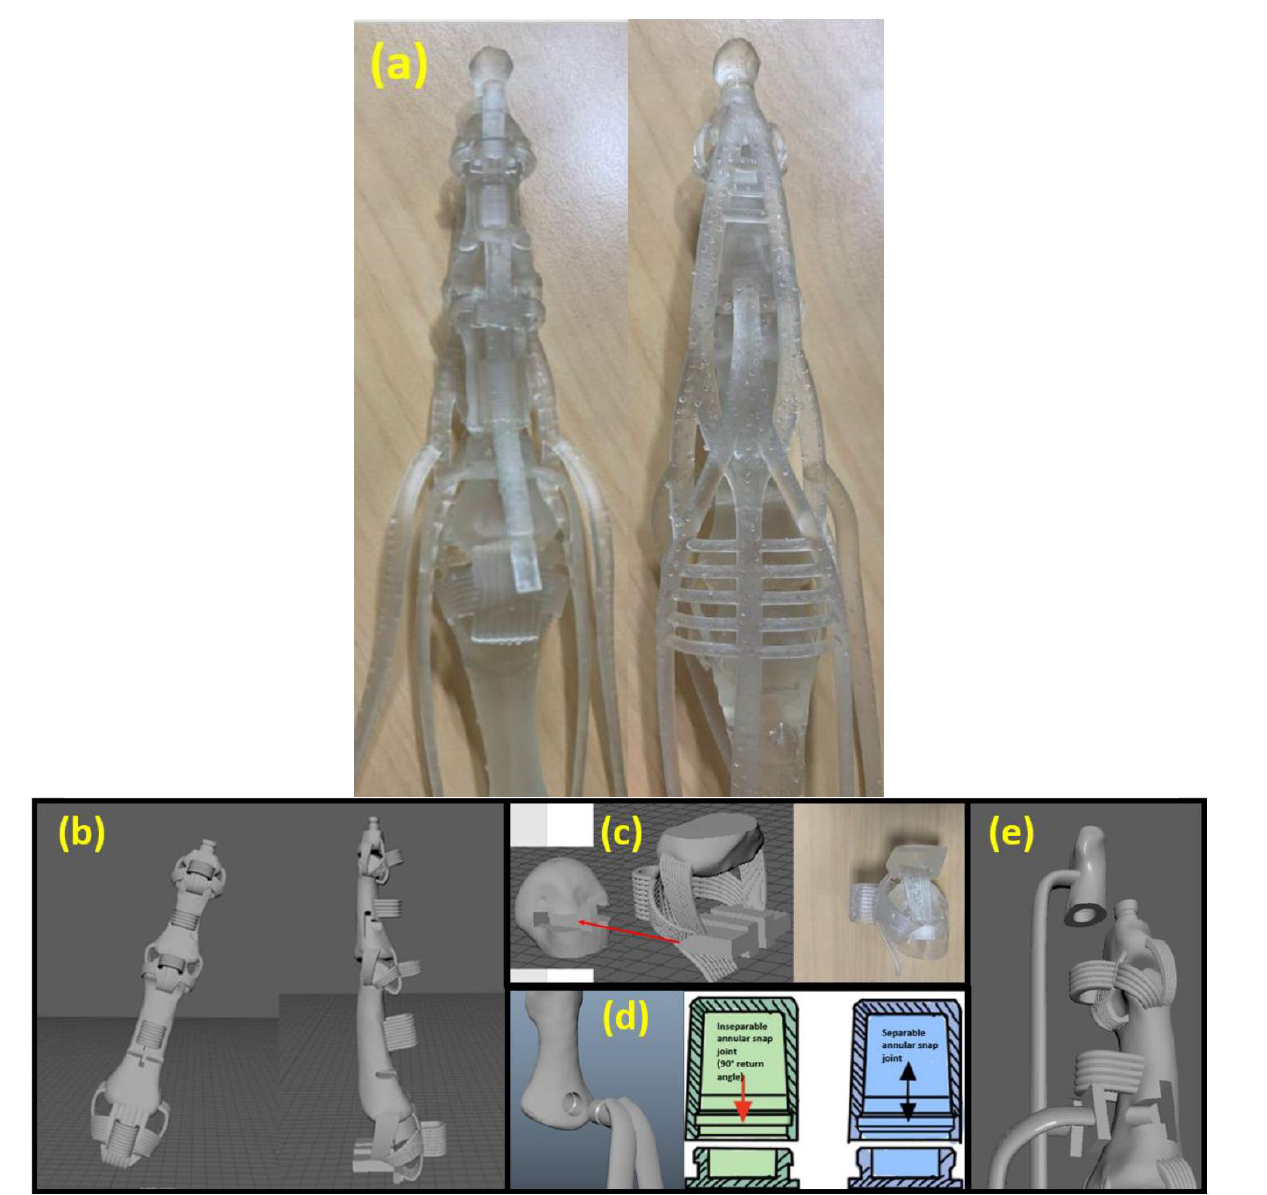
Figure 7. ( a ) Front and back view of our 3D-printed robotic finger; ( b ) 3D model of the index finger; ( c ) lap joint example for ligament connection at the MCP; ( d ) annular snap-fit joint for a extensor tendon; and ( e ) annular snap-fit joint for a flexor tendon.